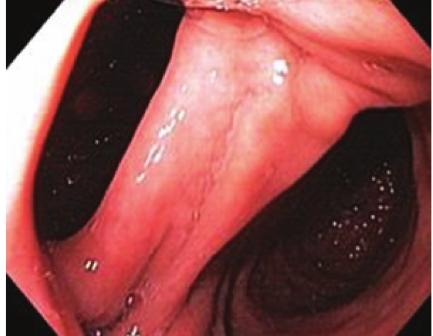
Figure 2: Gastrogastric fistula.